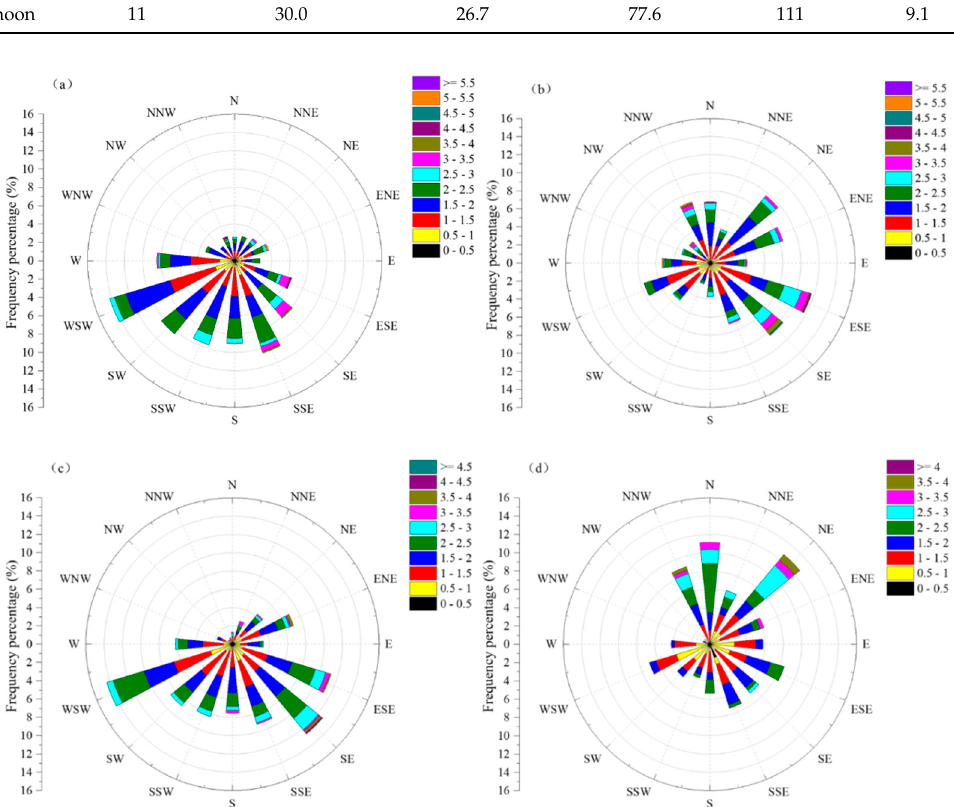
Figure 4. Meteorological parameters during different weather types: ( a ) case 1, ( b ) case 2, ( c ) case 3, and ( d ) case